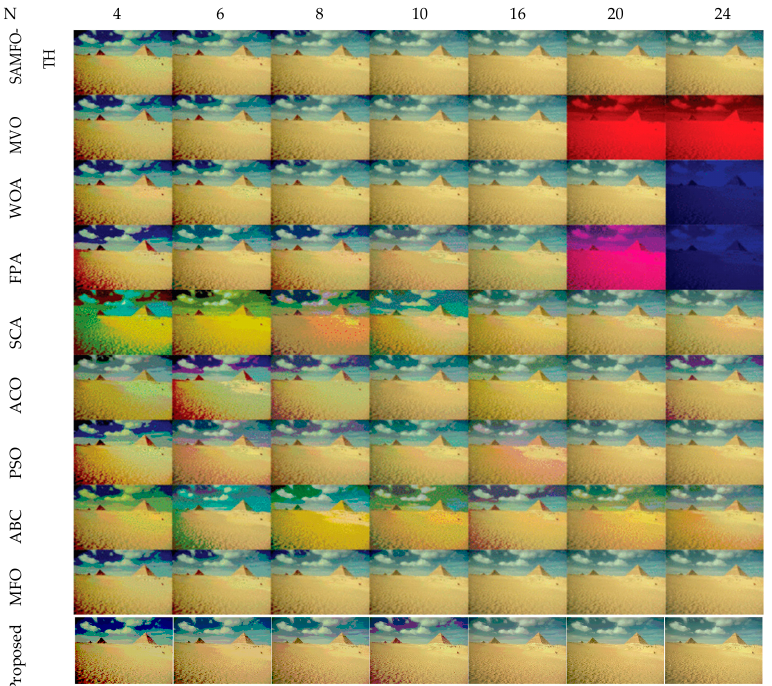
Figure 6. Segmented images of Image 6 at N = 4, 6, 8, 10, 16, 20, and 24, using SAMFO-TH, MVO, WOA, FPA, SCA, ACO, PSO, ABC, and MFO, and with the proposed model based on Otsu’s method.